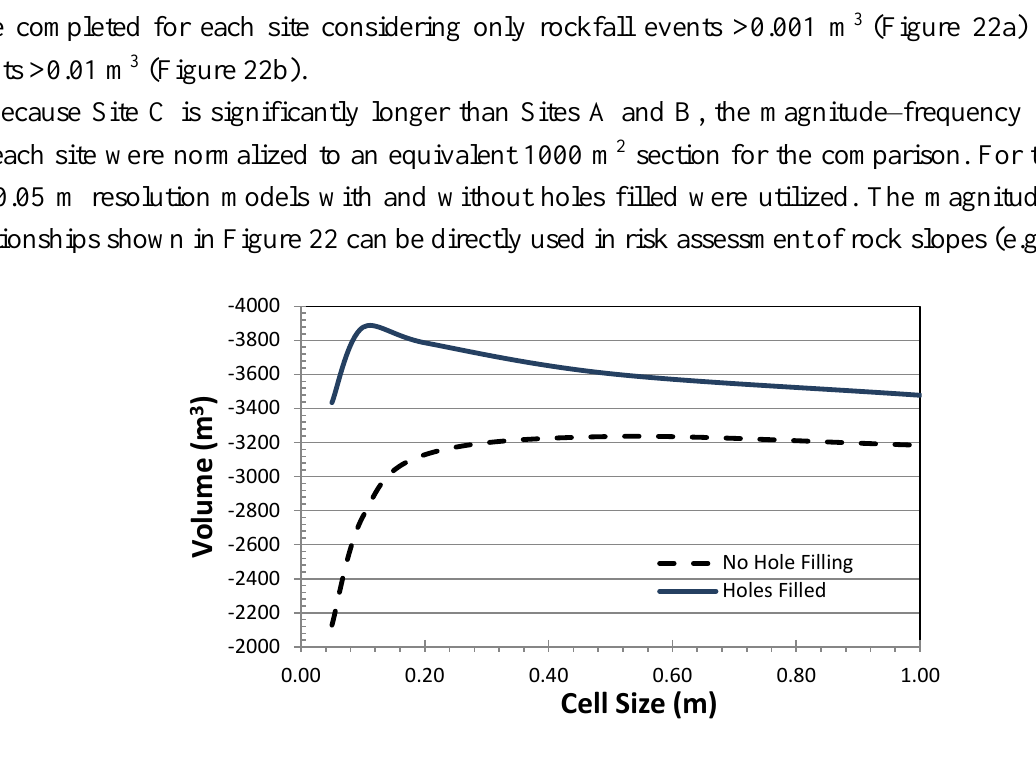
Figure 21. Comparison of calculated erosion volumes for various resolutions and with (HF) and without (NHF) hole filling at site GG239 between 2013 and